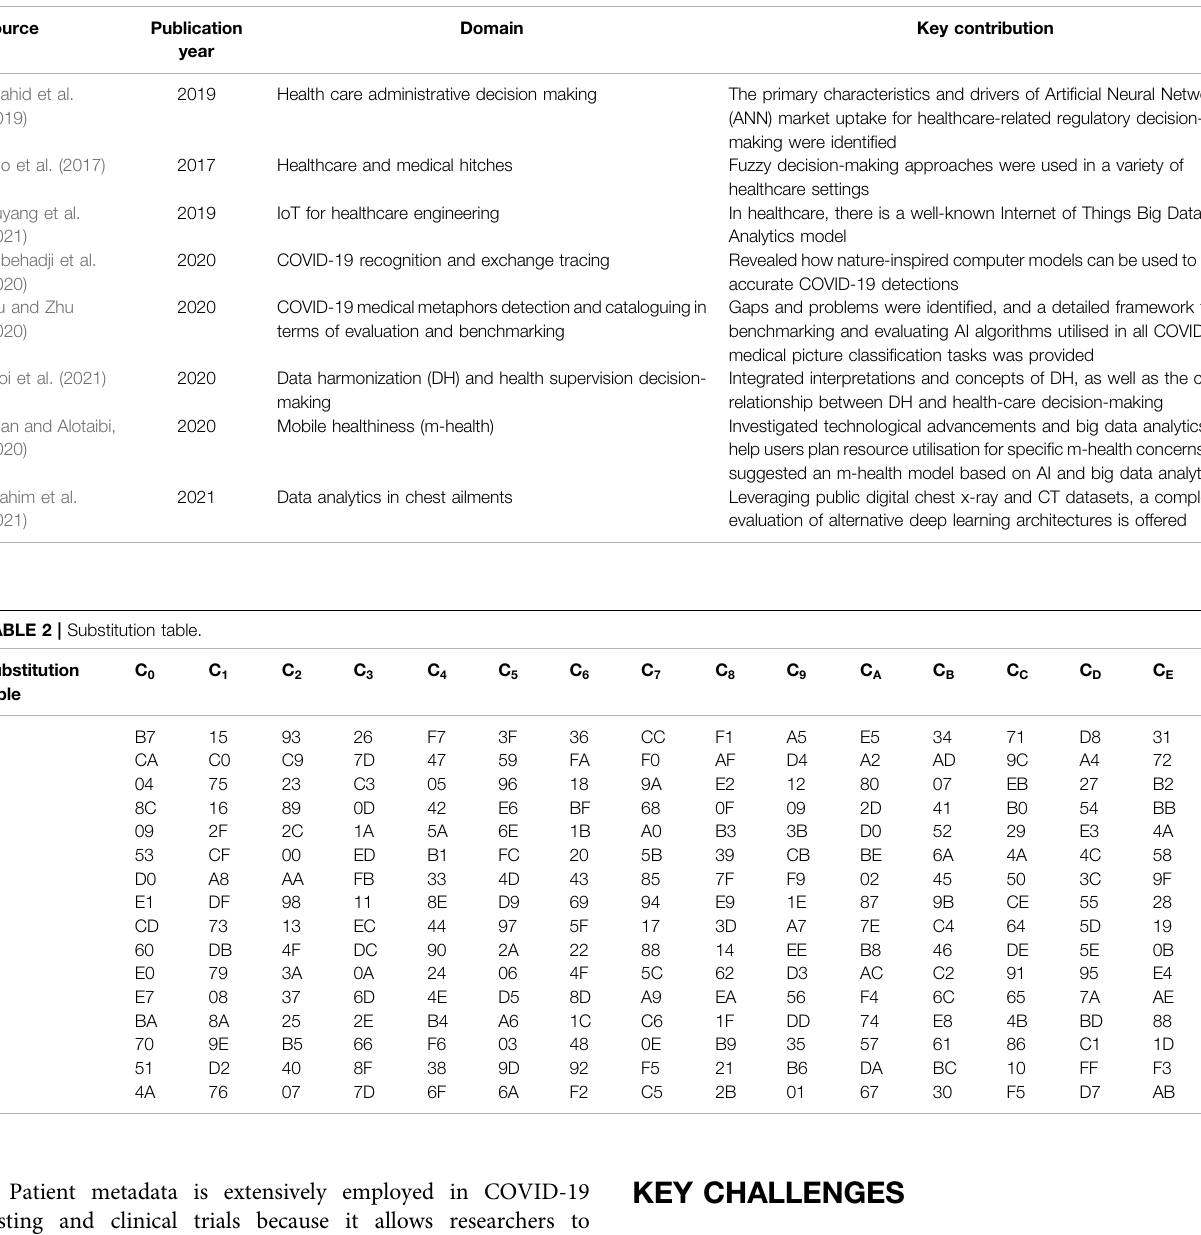
TABLE 1 | Summary of surveys on big data analytics in the healthcare fi